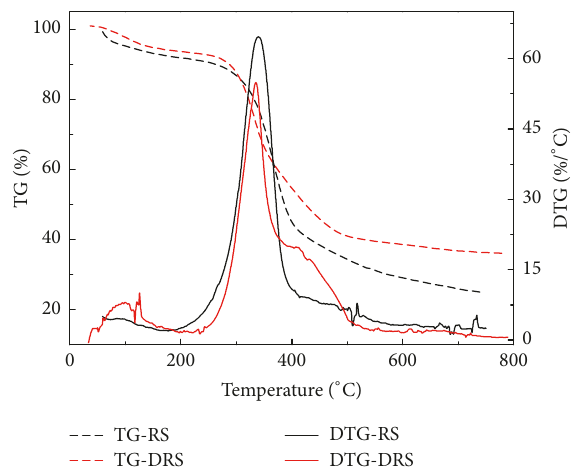
Figure 1: TG-DTG curves of RS and